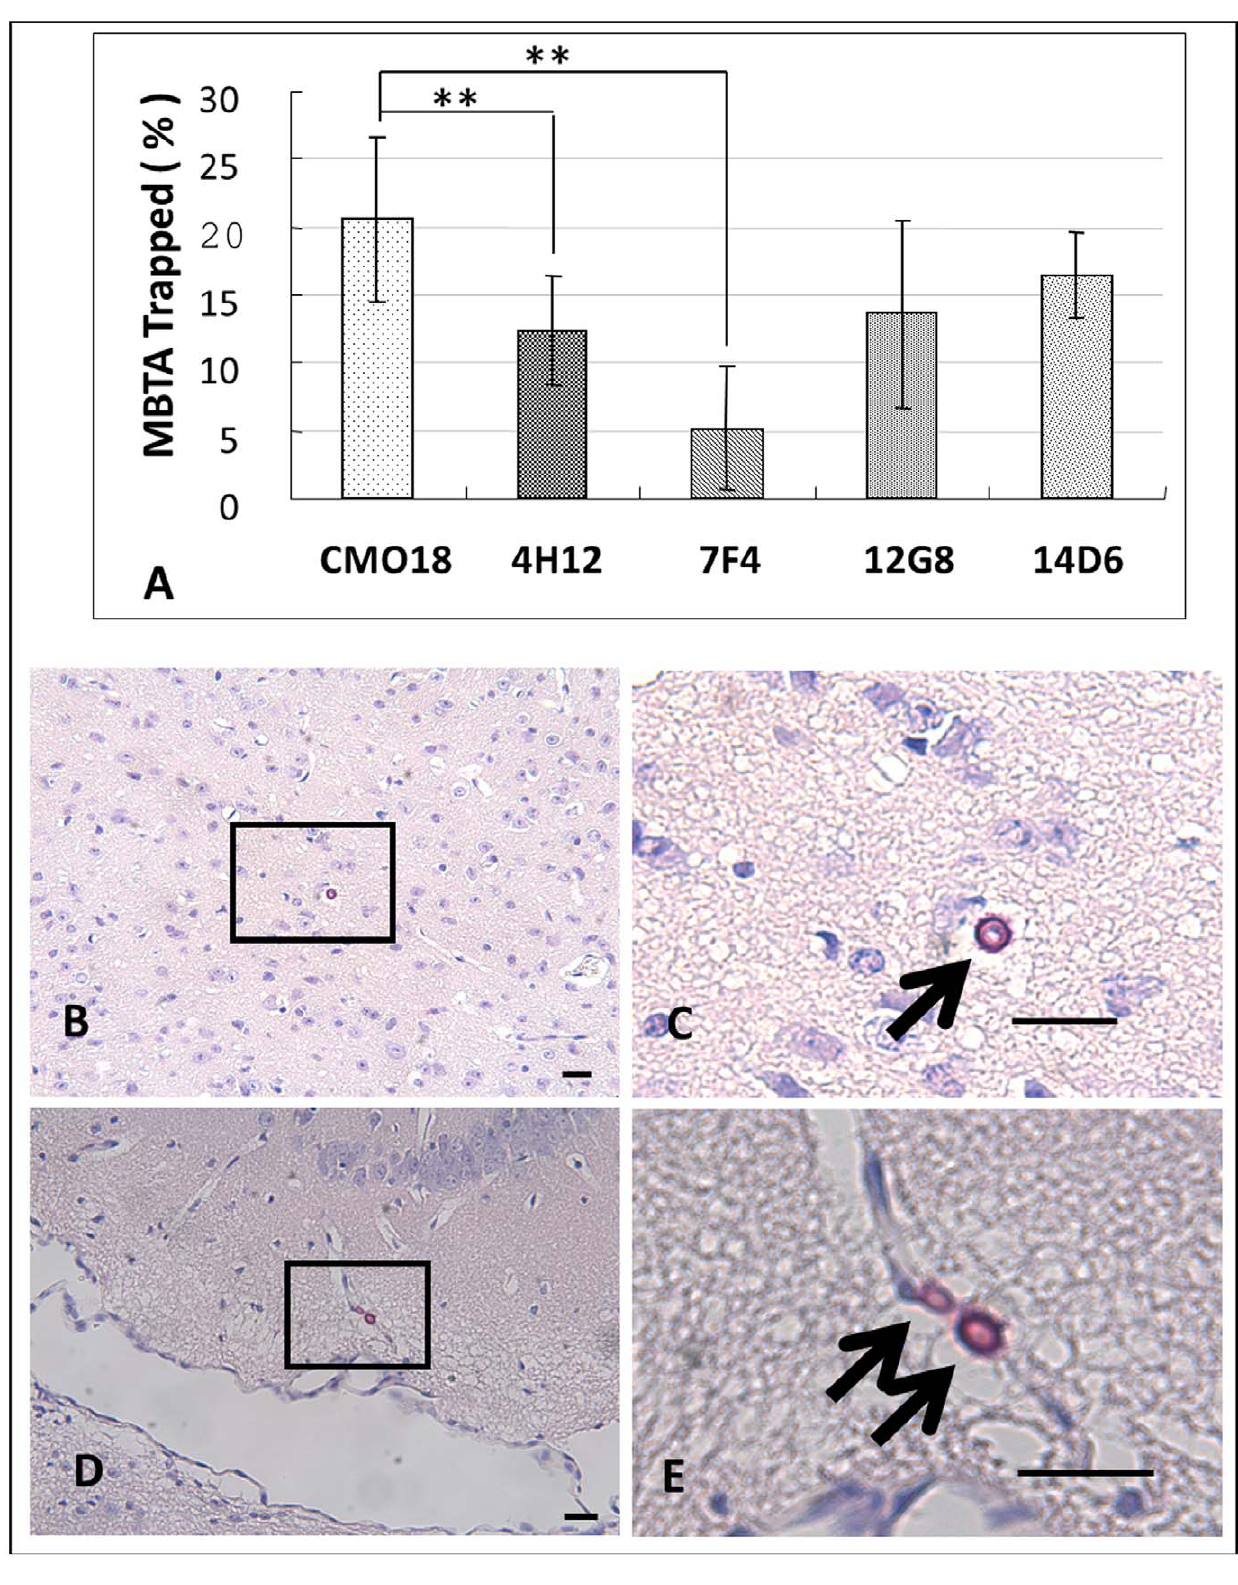
Figure 4. Entrapment MBTA. (A) Each yeast strain demonstrates different entrapped yeast percentage within vascular compartment. (B & C) Cryptococcus located in brain parenchymal (outside of microvessel); and (D & E) Cryptococcus trapped within the brain microvasculature (inside of microvessel). Yeast cells are stained with mucicarmine (arrow bar: 10 m m). P value is determined by Student’s t test.